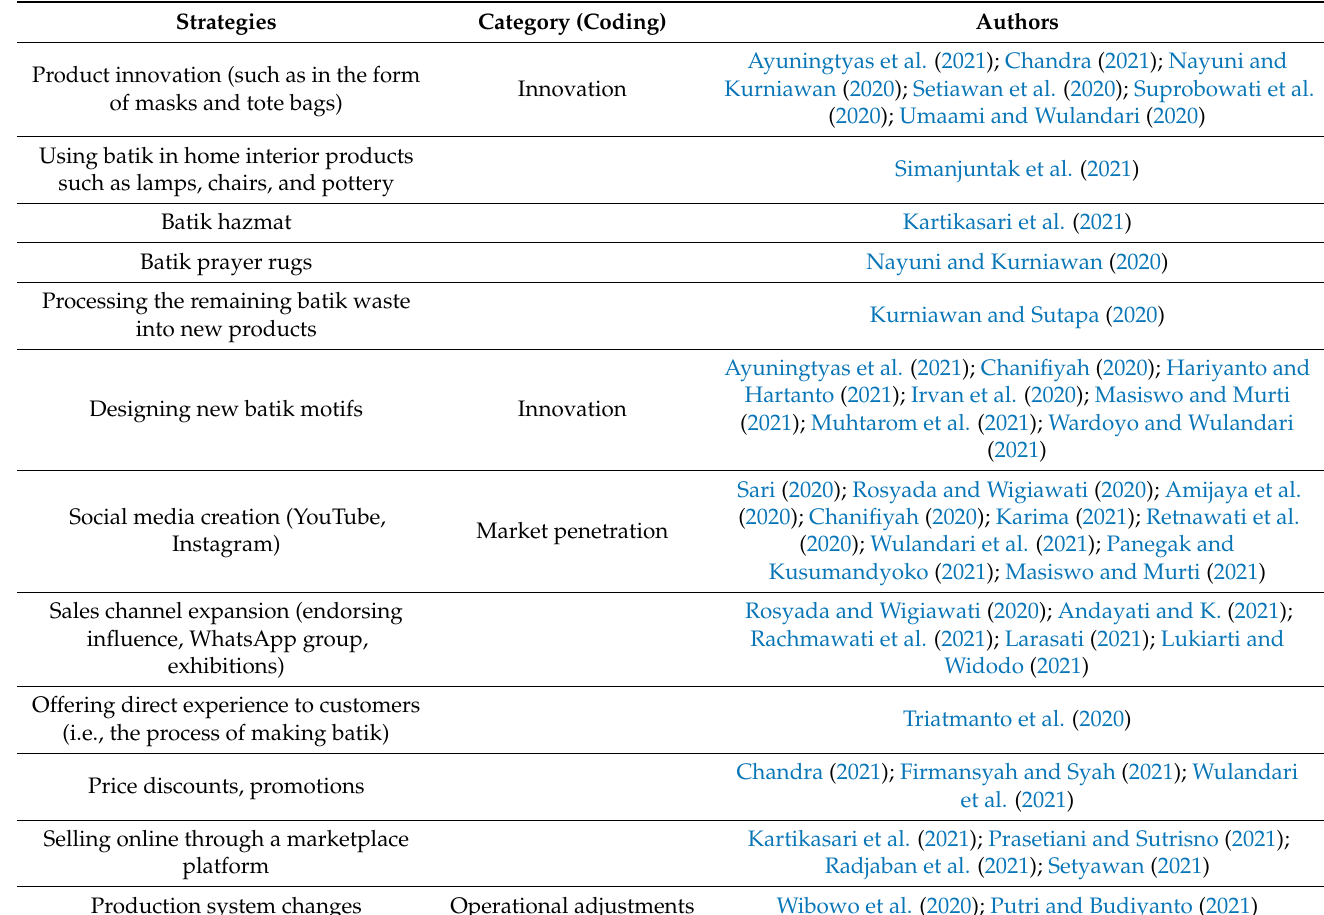
Table 2. Batik SMEs’ Strategies to Overcome Pandemic Impacts (Findings from